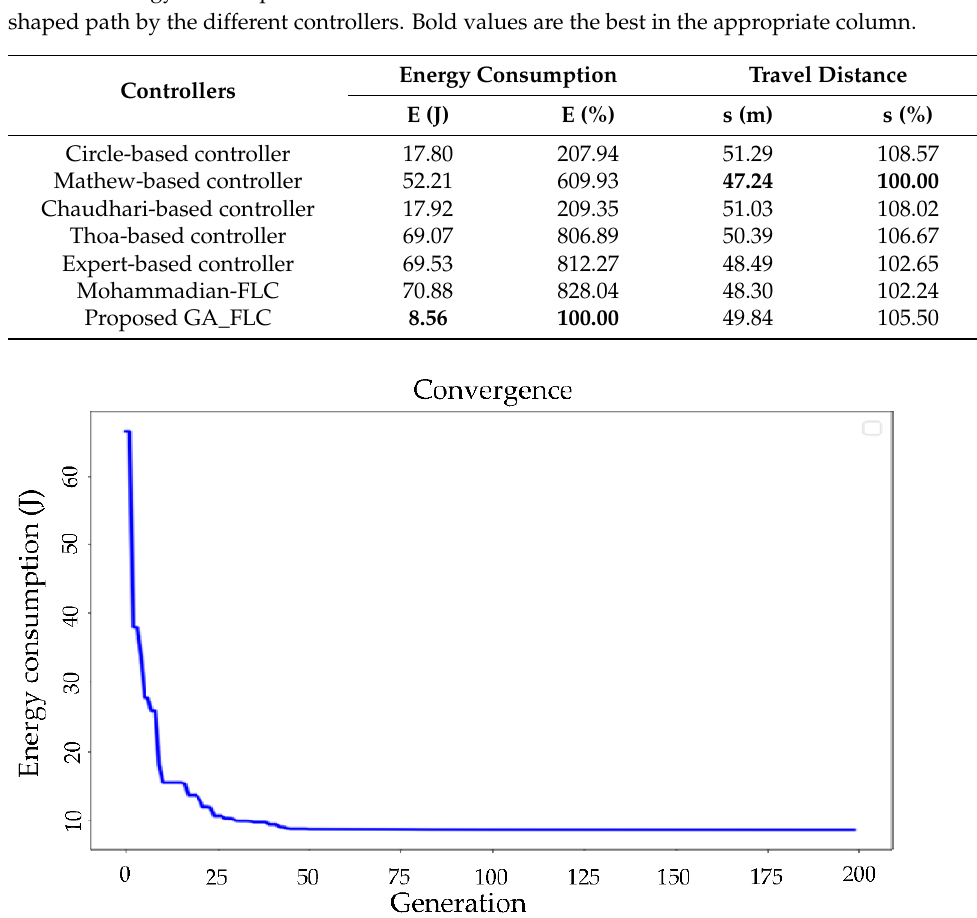
Figure 16. The convergence of energy fitness function. Table 10. Energy consumption and travel distance of the robot when the robot tracks the zigzag path based on optimizing by genetic algorithm. Bold values are the best in the appropriate column.